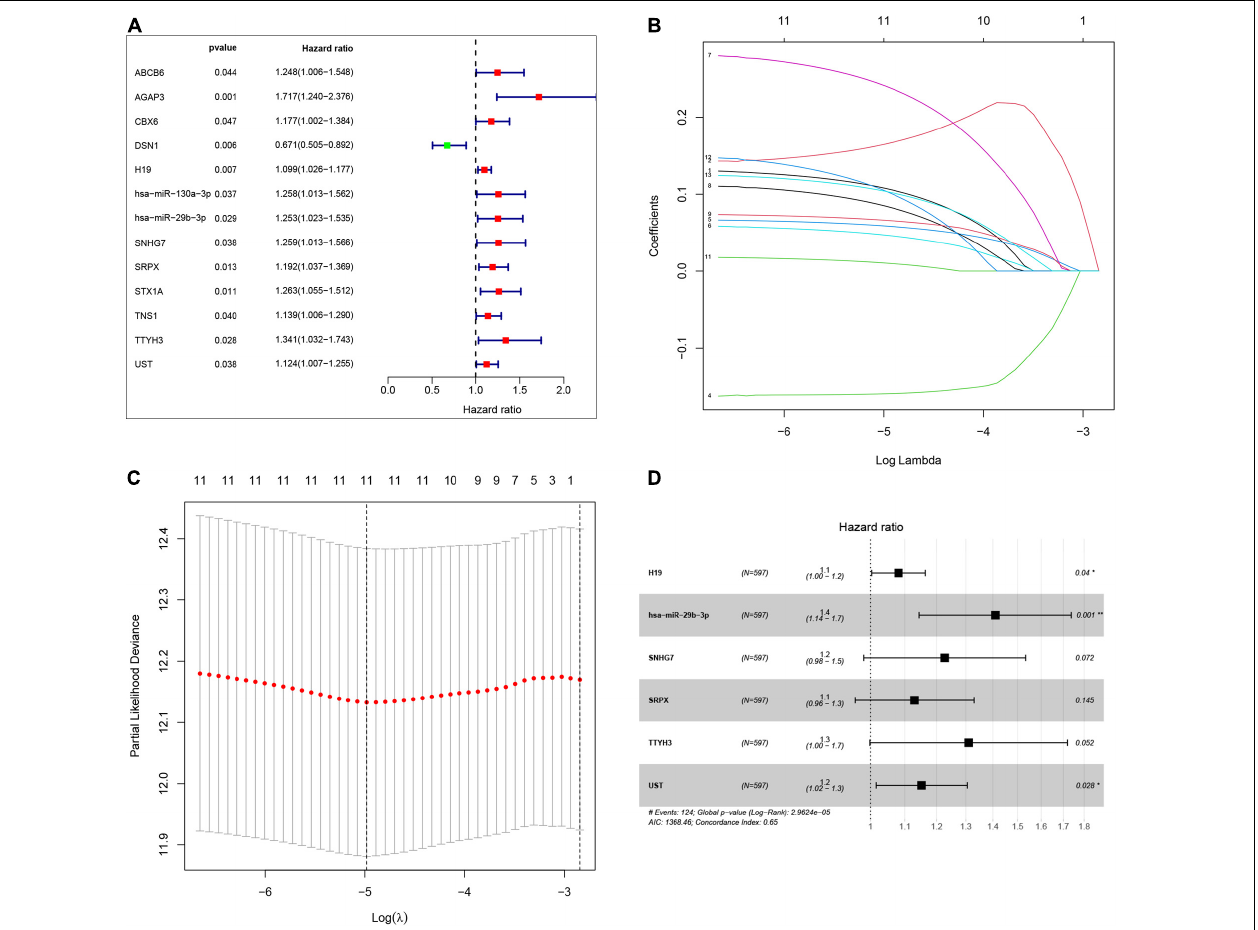
FIGURE 3 | By using univariate Cox regression analysis, we identified thirteen survival-associated genes in the our ceRNA network (A) . Lasso coefficient profiles of the 13 prognosis-associated genes from the discovery dataset (B) . Partial likelihood deviance of variables revealed by the Lasso regression model (C) . Finally, six genes were included for the establishment of prognostic model (D)